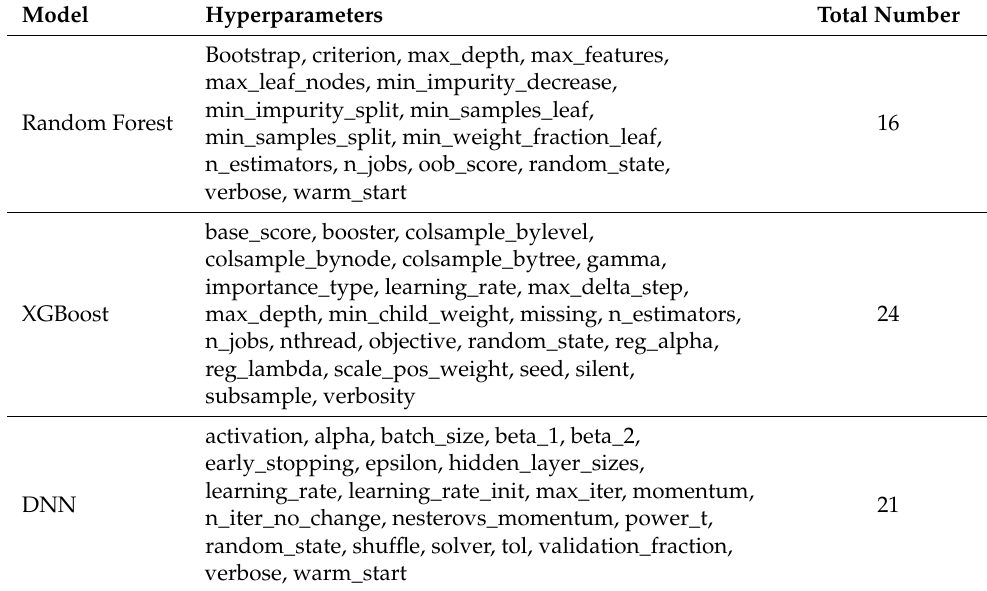
Table 1. Tunable hyperparameters in different machine learning regression models applied in this